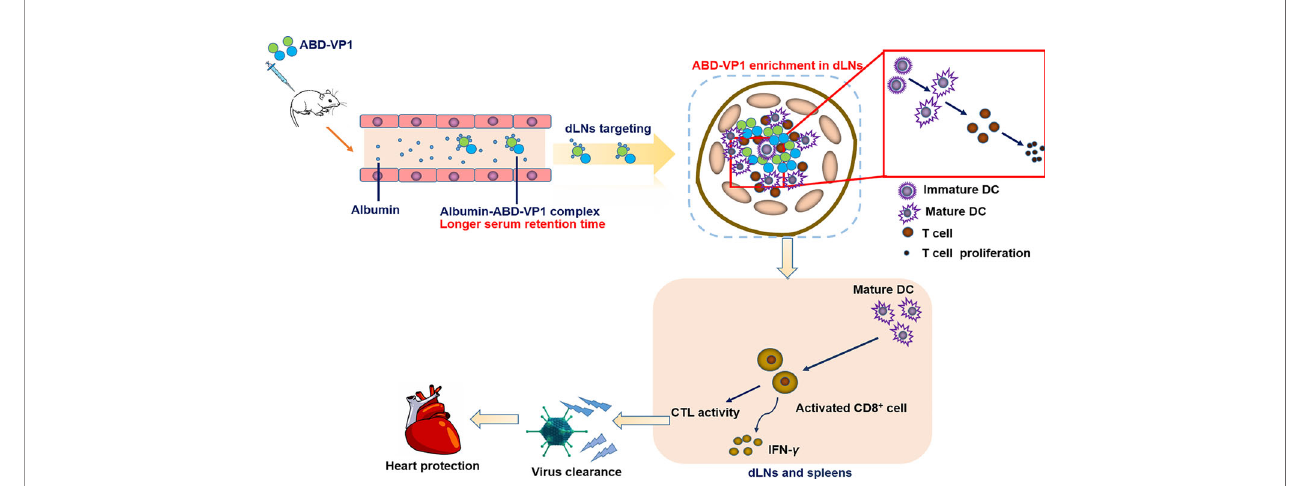
FIGURE 7 | Schematic representation of protection conferred by the dLNs-targeting ABD-VP1 vaccine against CVB3 -induced viral myocarditis. By forming complexes with albumins, ABD-VP1 vaccine possessed a longer serum half-life and the dLNs-targeting ability. It ef fi ciently recruited and promoted the maturation of DCs, and elicited more robust CVB3 -speci fi c T cell immune responses as well as a higher level of serum neutralizing antibodies. Accordingly, ABD-VP1 vaccine provided enhanced immunoprotection against CVB3 -induced myocarditis compared with the original VP1